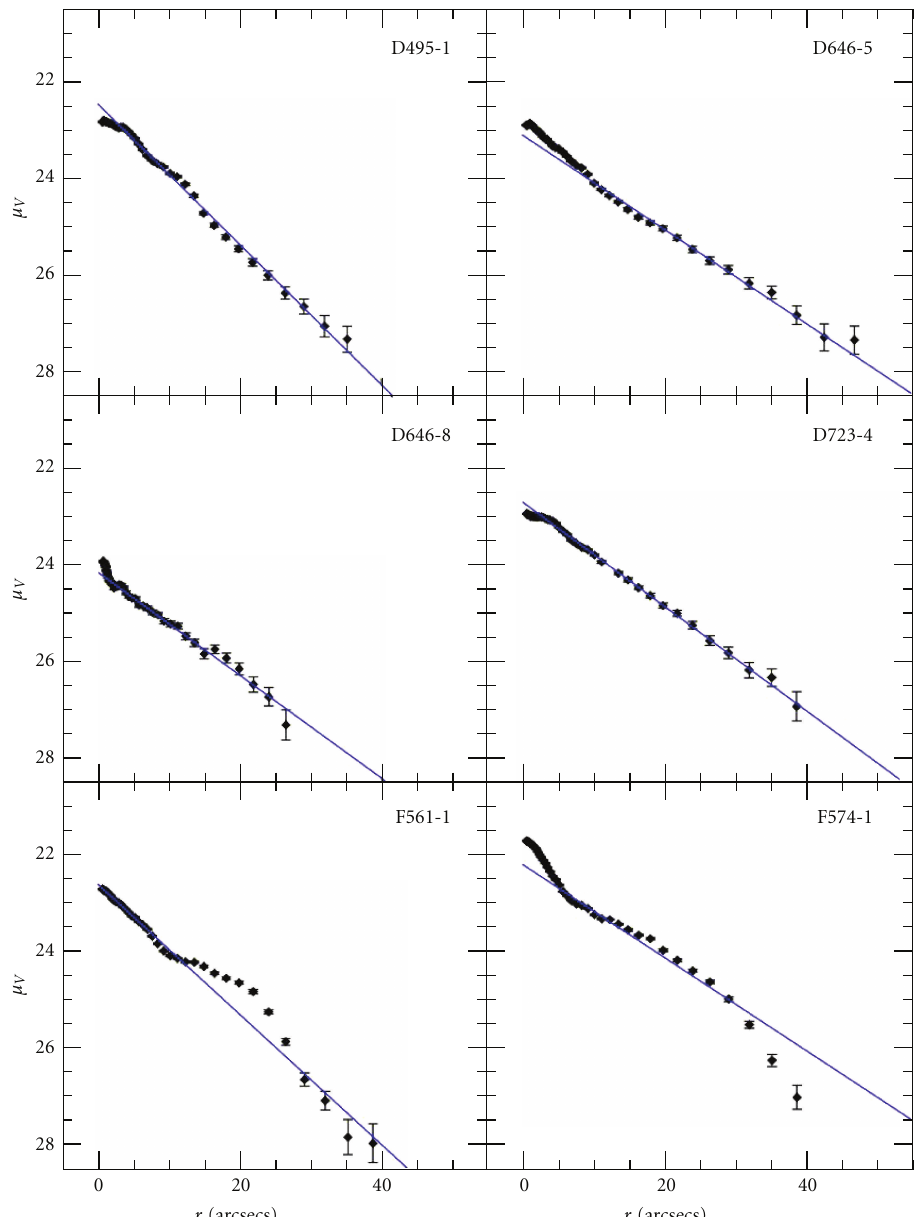
Figure 3: Surface brightness profiles for six galaxies. Best-fit exponentials are shown in blue. Fits are constrained to the outer portions of the galaxy with the clearest linear